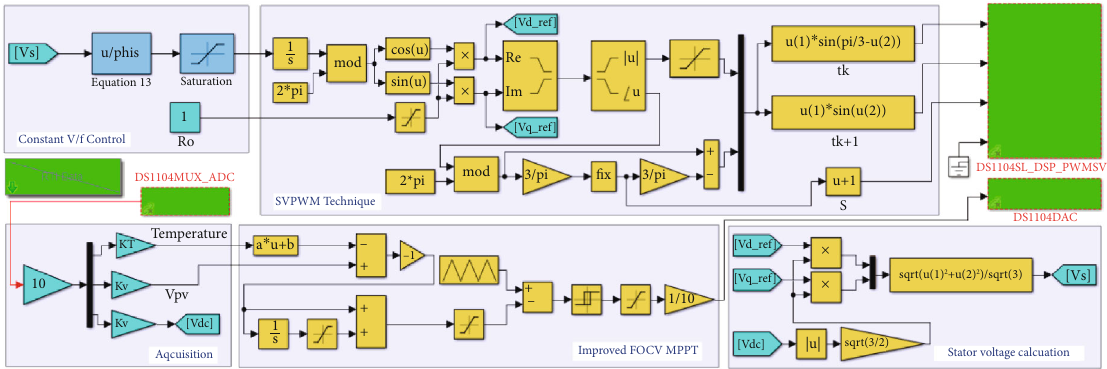
Figure 13: Simulink model of the implemented main RCP